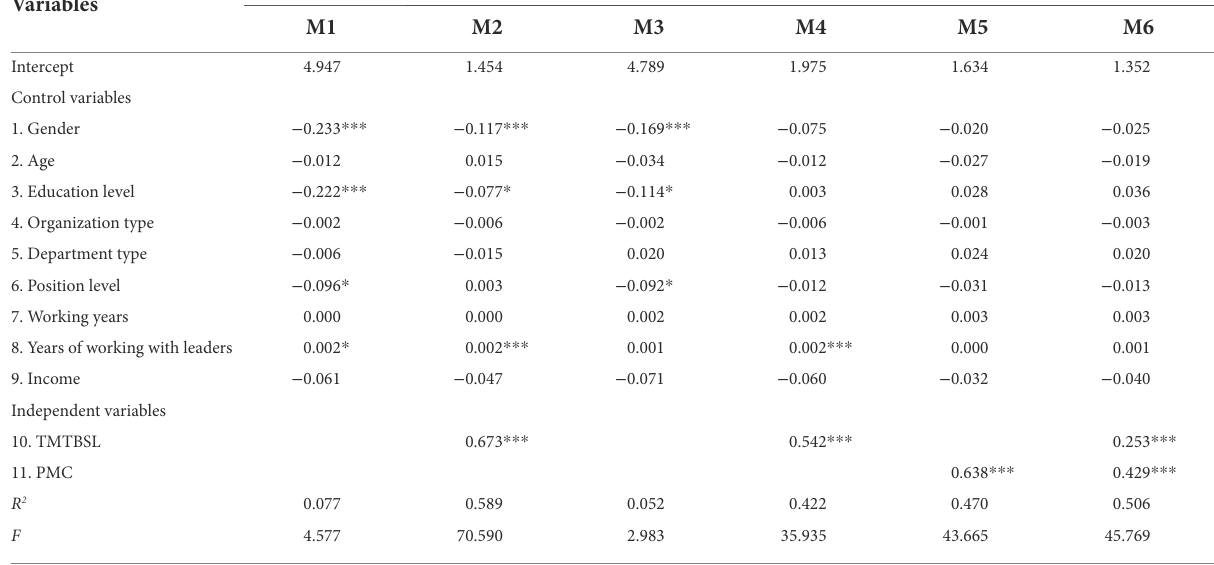
TABLE 7 Hierarchy regression results of all variables in Study 2.